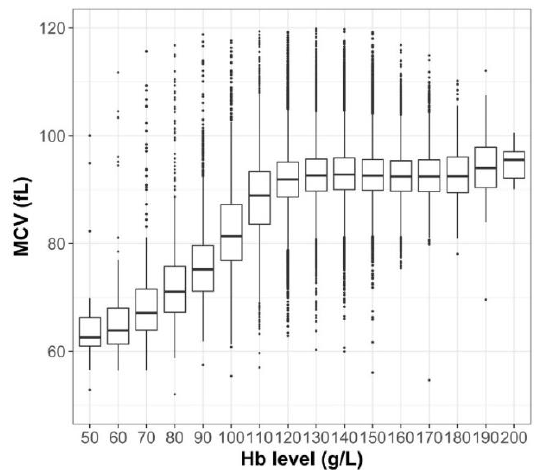
Figure 1. Distribution of mean corpuscular volume, by hemoglobin (Hb) value. The horizontal line in the middle of each box indicated the median, and the top and bottom borders of the box mark the 75th and 25th percentiles, respectively. The whiskers above and below the box mark represent the upper and lower adjacent data, covering >99% of the data range. Outliners are presented in dots. Hb values were grouped after rounding to the nearest integer. MCV — mean corpuscular volume.